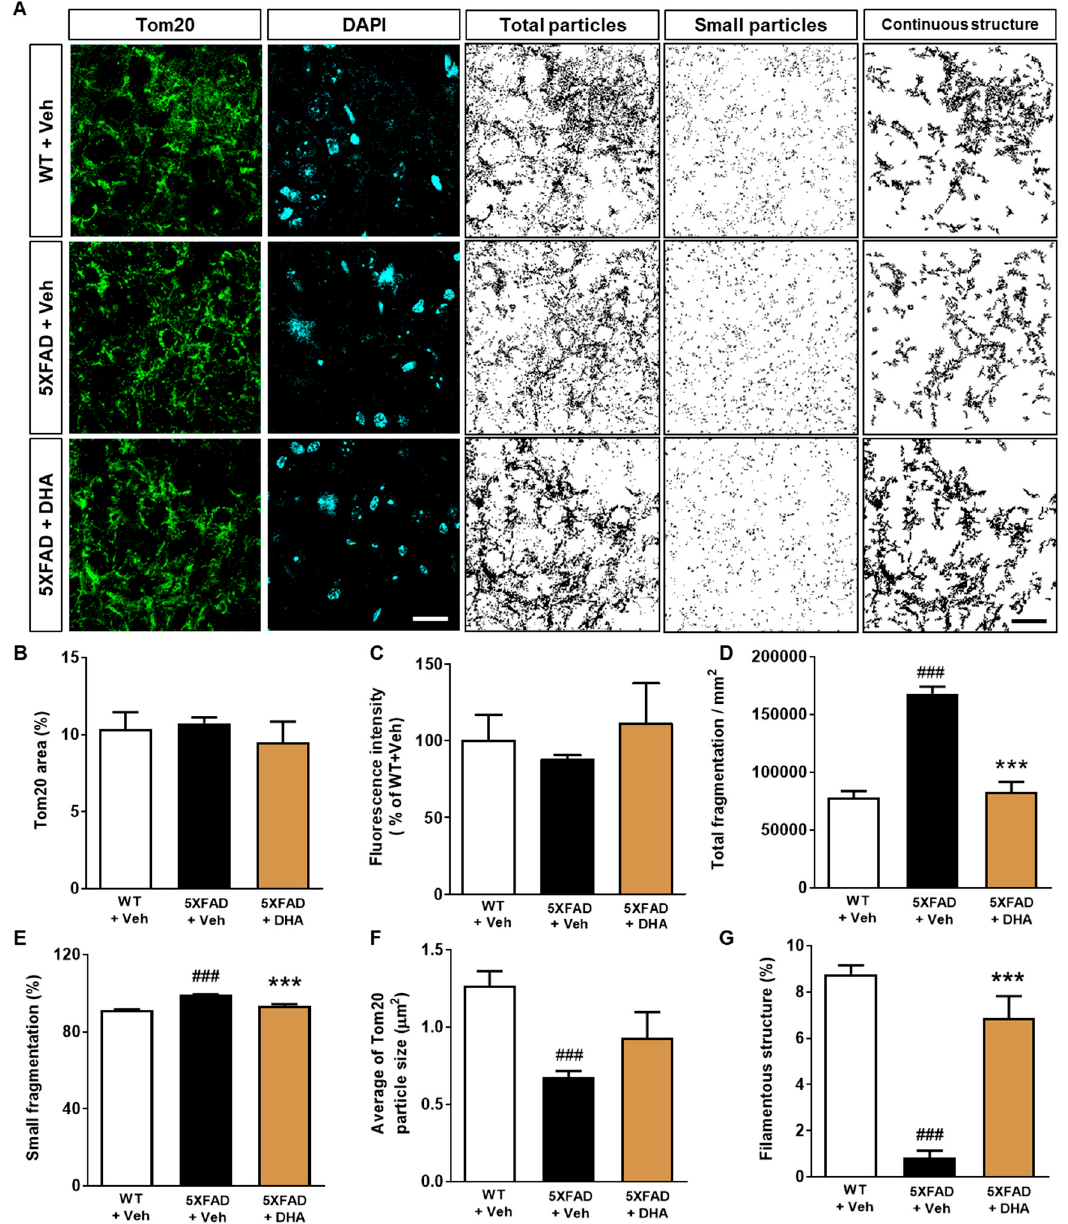
Figure 4. Effects of DHA on mitochondrial dynamics altered by A β accumulation in the 5XFAD mice. ( A ) Immunofluorescence staining against Tom20 was performed to visualize the mitochondrial dynamics in the dorsal subiculum (scale bar = 20 µ m). ( B ) Fraction of Tom20-positive area plotted as a percentage. ( C ) The fluorescence intensity of Tom20 was normalized to that observed in vehicle-treated WT mice. The immuno-positive area of Tom20 was classified according to the size to demonstrate mitochondrial fusion and fission, to allow quantification of the following factors: total fragmentation ( D ), proportion of small fragmentation (%) ( E ), proportion of filamentous structures (%) ( F ), and average Tom20 particle size ( G ). Data are presented as mean ± SEM (42 images / 7 mice). ### p < 0.001: vehicle-administrated WT mice versus vehicle-administrated 5XFAD mice. *** p < 0.001: vehicle-treated 5XFAD mice vs. DHA-treated 5XFAD